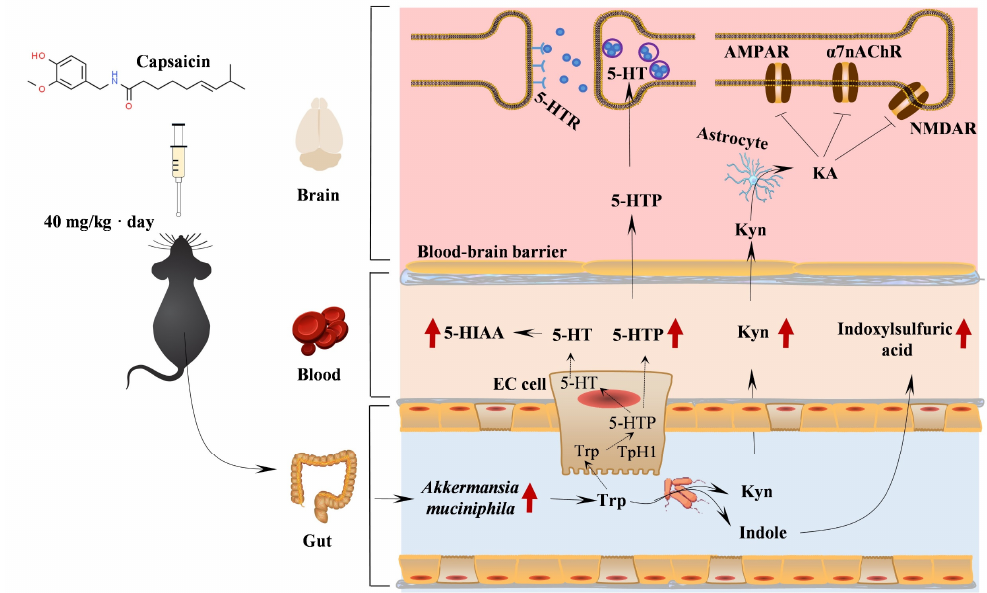
Figure 6. The interaction between the microbiota and the microbiota – gut – brain axis in APP/PS1 mice and capsaicin intervention. Dietary capsaicin can directly change gut microbiota compositions and significantly enhance the relative abundance of A. muciniphila , which contributed to Trp secretion. Almost all free Trps are involved in the Kyn pathway (KP) related to Trp degradation and the gut microbiota influence the kynurenine-producing indoleamine-2,3-dioxygenase (IDO) pathway. Kynurenine amino transferase in astrocytic cells can transfer from Kyn to kynurenic acid (KA), which regulates cognition and behavior using three receptors, including the α 7-nicotinic receptor ( α 7nAChR), N-methyl-d-aspartate receptors (NMDARs), and α -amino-3-hydroxy-5-methyl- 4-isoxazolepropionic acid receptors (AMPARs) [28]. The peripheral production of 5-HT and 5-HTP by enterochromaffin (EC) cells is also affected by the gut microbiota. 5-HTP, transported across the blood–brain barrier, is further metabolized into 5-HT, which exhibits neurobiological functions using 5-HT receptors in AD [48]. Gut microbial tryptophanase converts Trp into indole, and then it enters the host portal circulation and is transferred into indoxylsulfuric acid in the liver [49]. The red arrows represent the higher abundance of gut microbiota and increased serum metabolites in capsaicin-treated APP/PS1